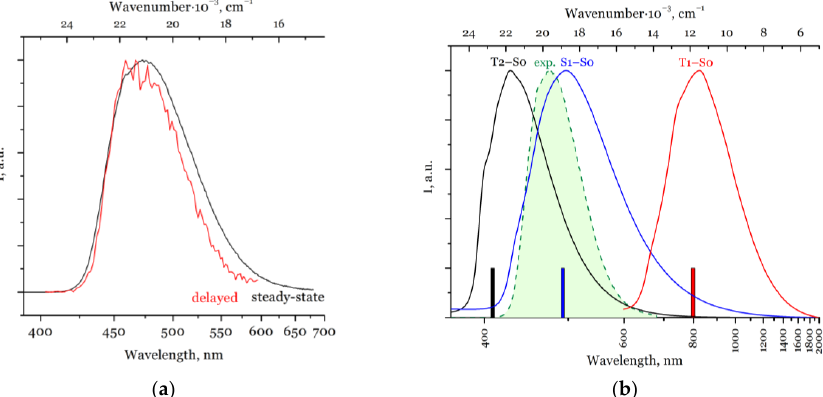
Figure 5. ( a ) Experimental normalized steady-state and delayed (after 300 µ s) emission spectra of solid sample 1 (excitation wavelength 350 nm). ( b ) Experimental steady-state emission spectrum of 1 (dashed line) and the corresponding calculated vibrationally resolved emission spectra (solid lines) for the transitions from the triplet (T 1 and T 2 ) and singlet (S 1 ) states. Vertical bars indicate the corresponding TD-DFT-computed emission energies of the transitions.